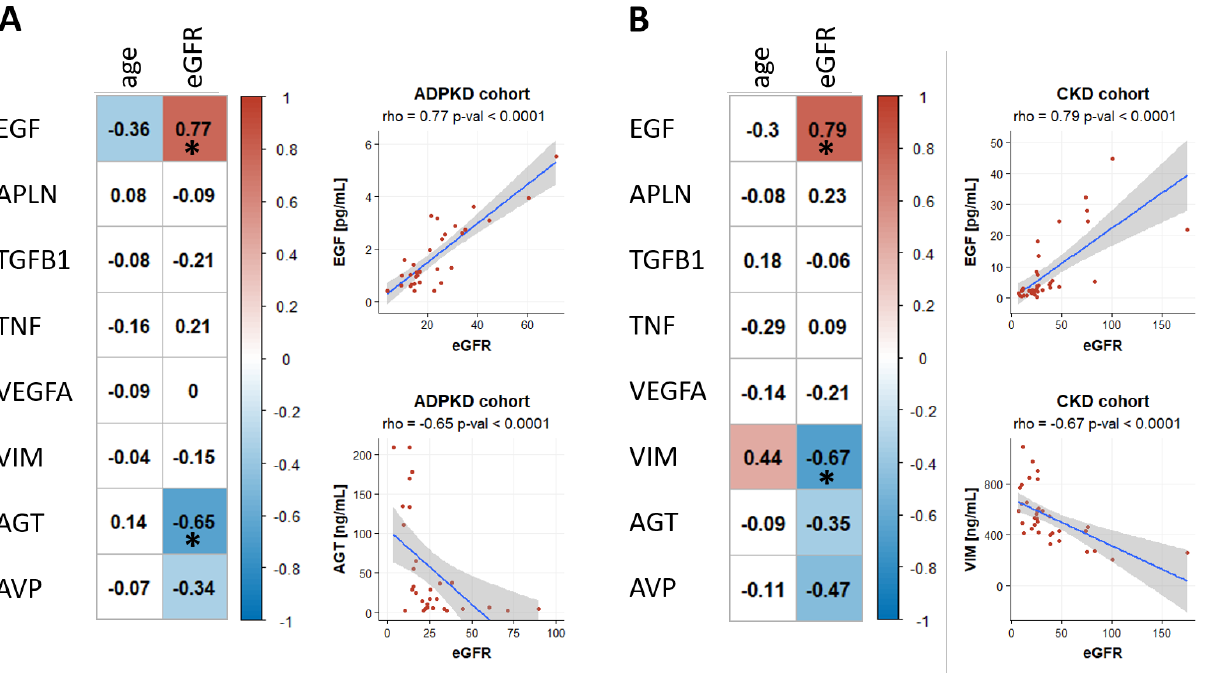
Figure 2. Correlations of biomarker levels with age and eGFR are given when analyzing samples from the ADPKD cohort (panel A ) as well as samples from the CKD cohort (panel B ). The Spearman correlation coefficient was used. Significant correlations with p < 0.05 are highlighted with colored background. An asterisk (*) indicates correlations also being significant after Bonferroni correction for multiple testing. The EGF outlier with a value of 44.49 was omitted in the scatterplot visualizations for clarity. The value was however included in the correlation analysis.